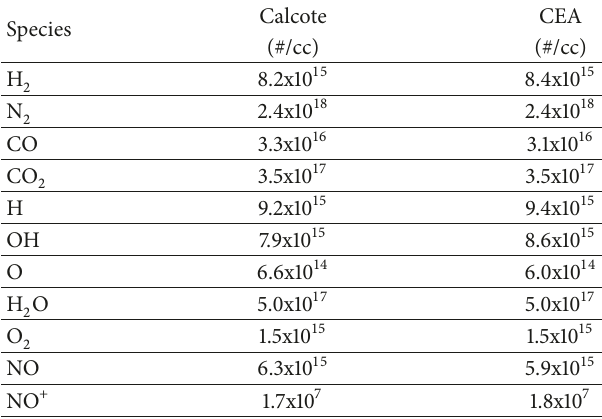
Table 1: Comparison of equilibrium concentrations (Calcote and CEA).